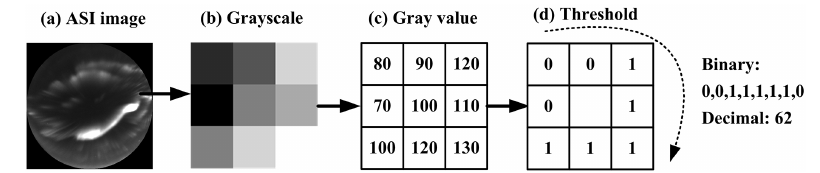
Figure 1. Calculation process of the basic LBP